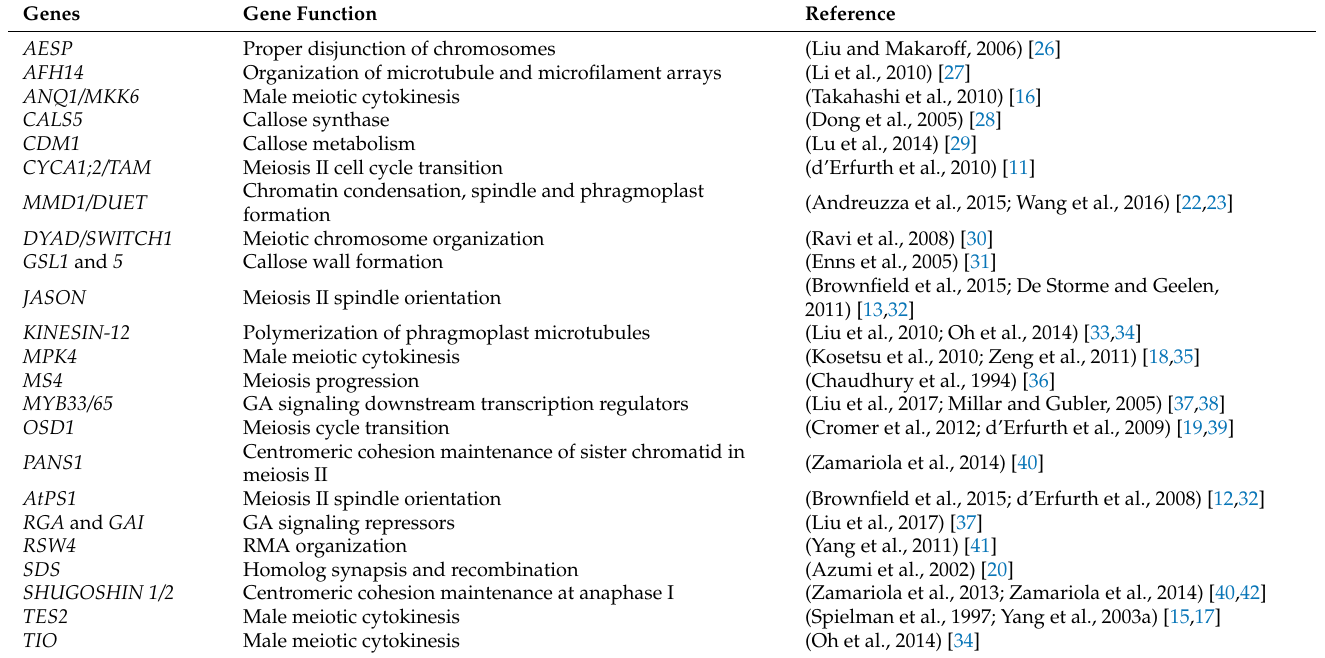
Table 1. Genes, dysfunction of which may cause male meiotic restitution in Arabidopsis thaliana . Genes Gene